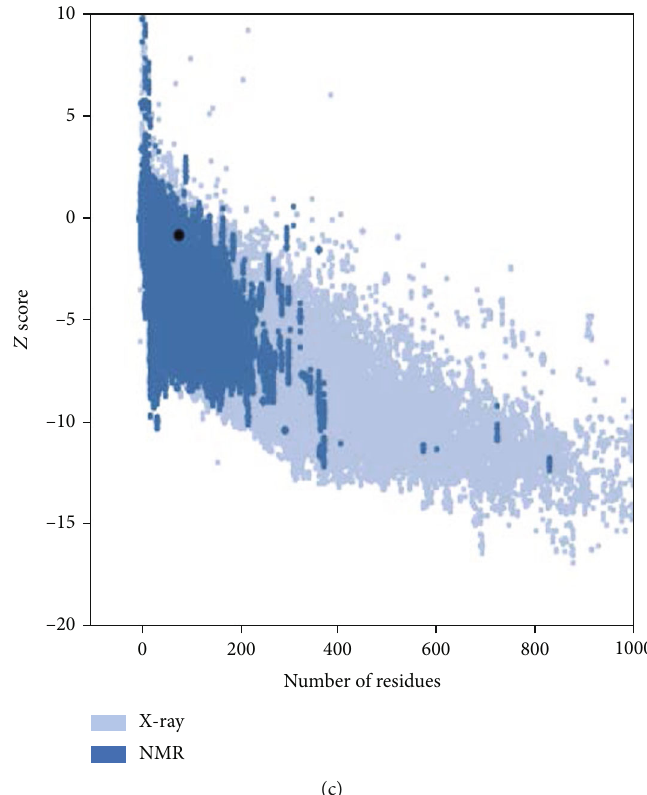
Figure 7: (a) Three-dimensional structure of vaccine predicted by I-TASSER. Three-dimensional structure prediction validation of top score model of I-TASSER by (b) RAMPAGE assessment of the Ramachandran plot of the selected model. Number of residues in favored region: 53 (69.7%), number of residues in allowed region: 20 (26.3%), number of residues in outlier region: 3 (3.9%). (c) ProSA protein structure analysis results. Z score = − 0 : 79 . Overall quality of the ultimate model is acceptable.